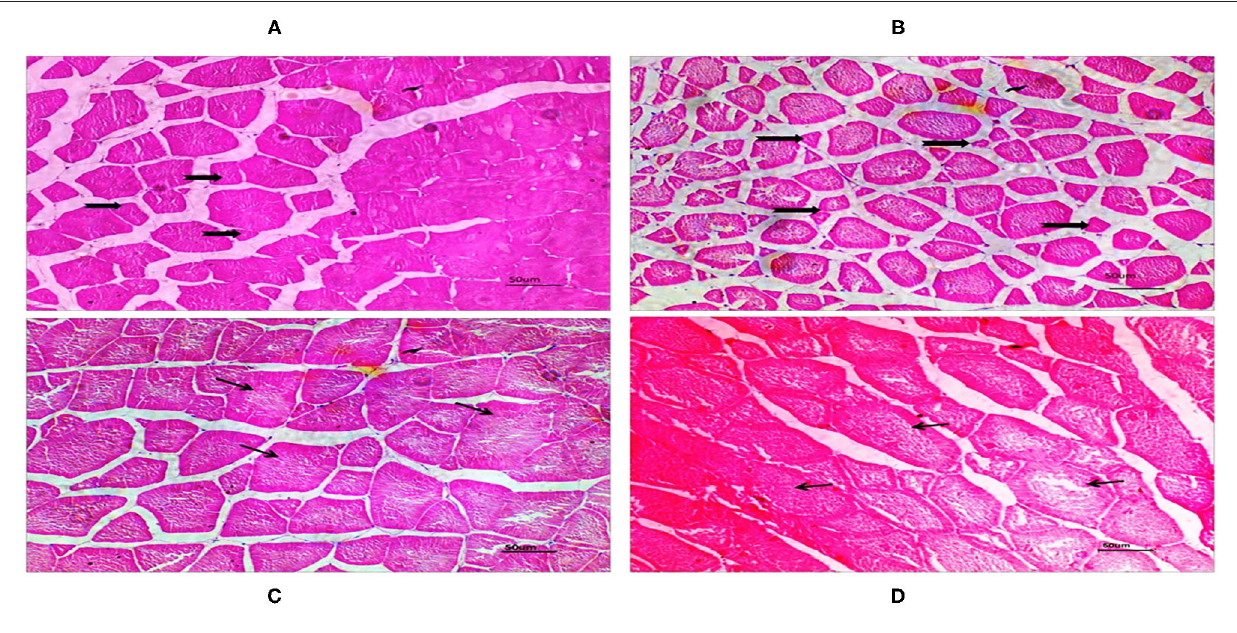
FIGURE 2 | The cross-sections of dorsal muscle in juvenile grass carp with H&E (200 × ). Native DDGS20 and DDGS30 groups (A,B) showed increased muscle fiber density, while small fiber diameter. US-imported DDGS20 and DDGS30 groups (C,D) showed opposite